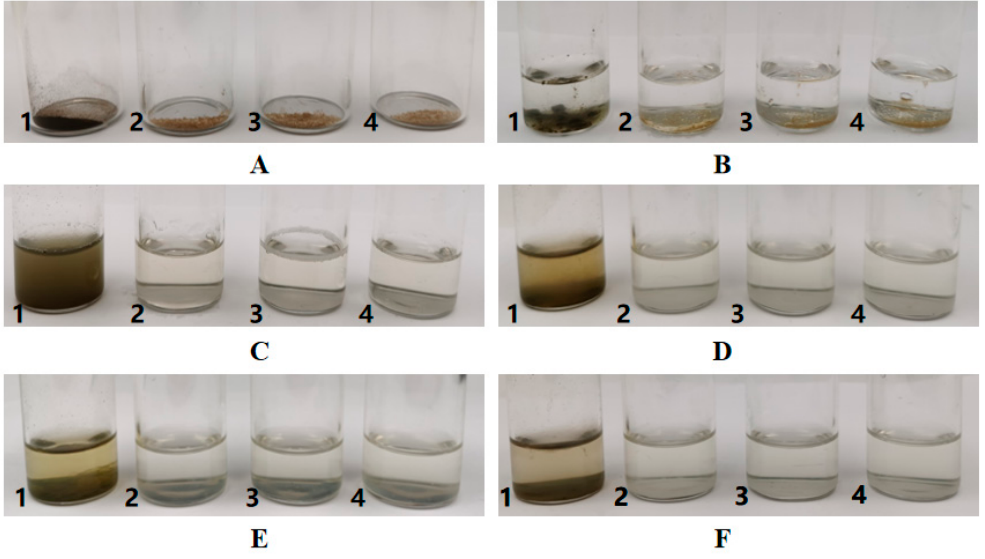
Figure 3. Stability of free phlorotannin (1) and PPNPS (1:6(2), 1:8(3), 1:10(4)) at room temperature (22 ± 3 °C) (A: Original state; B: Adding water; C: Mixture; D: Standing for 5 days; E: Standing for 10 days; F: Standing for 15 days). The concentration of every sample was 20 mg/mL (100 mg solid sample mixed with 5 mL water).